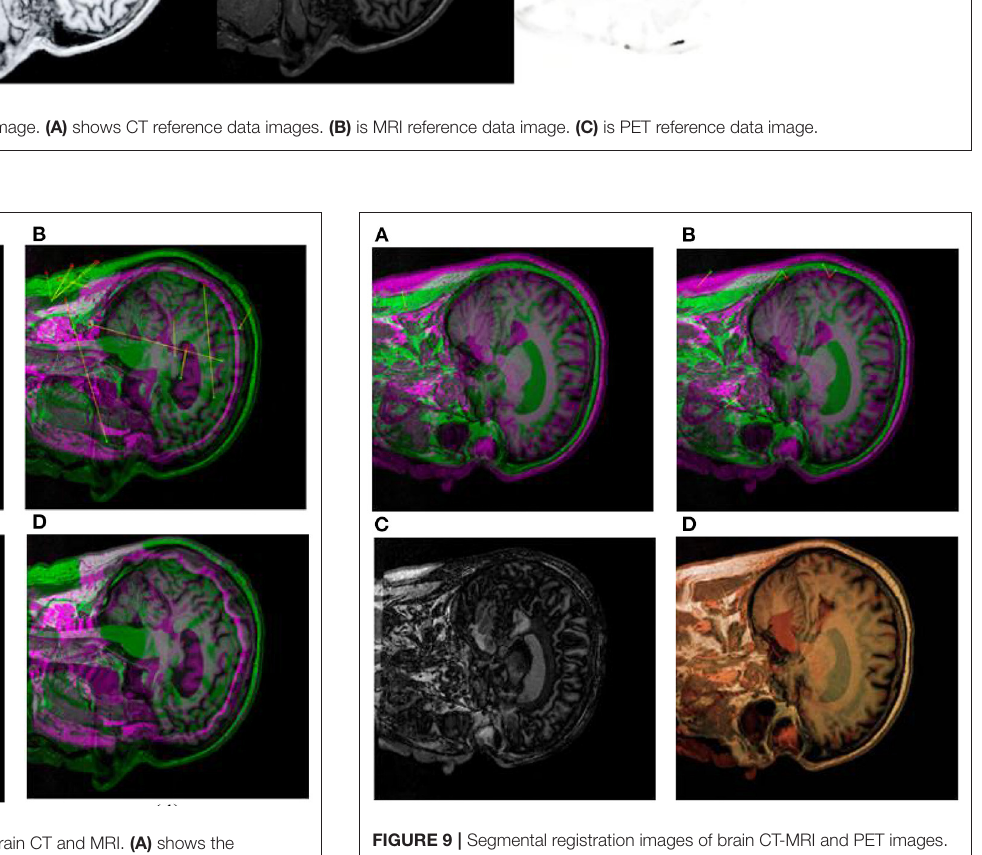
FIGURE 8 | Registration images of brain CT and MRI. (A) shows the pre-processed initial registration image. (B) medical images after multi-modal registration. (C) is affine transformation global rough registration of medical images. (D) represents medical image with high precision registration after non-rigid transformation.